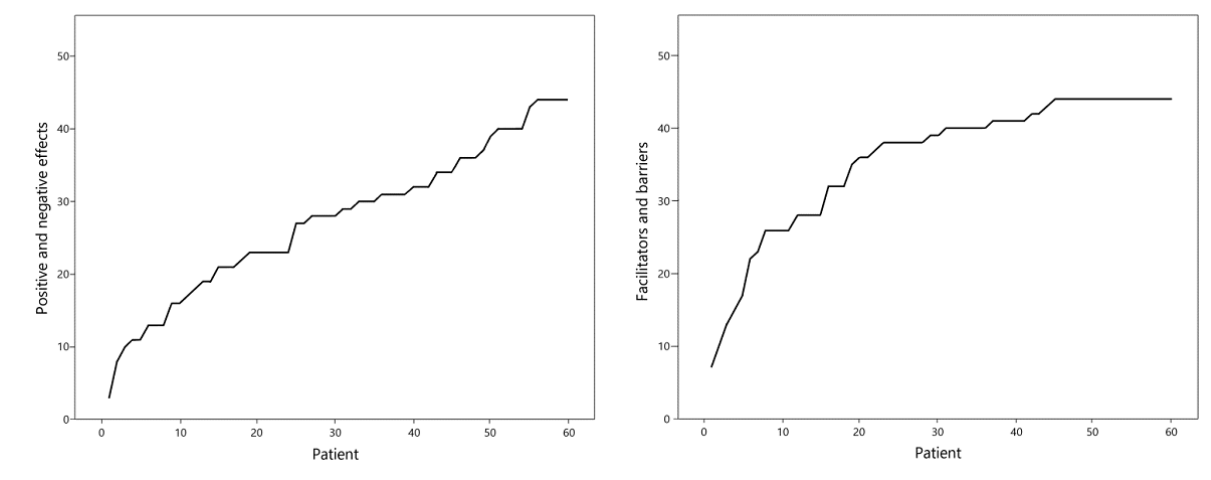
Figure 1. Saturation of positive and negative effects and facilitators and barriers. X-axis represents number of patients interviewed; Y-axis represents the accumulated number of new items mentioned by